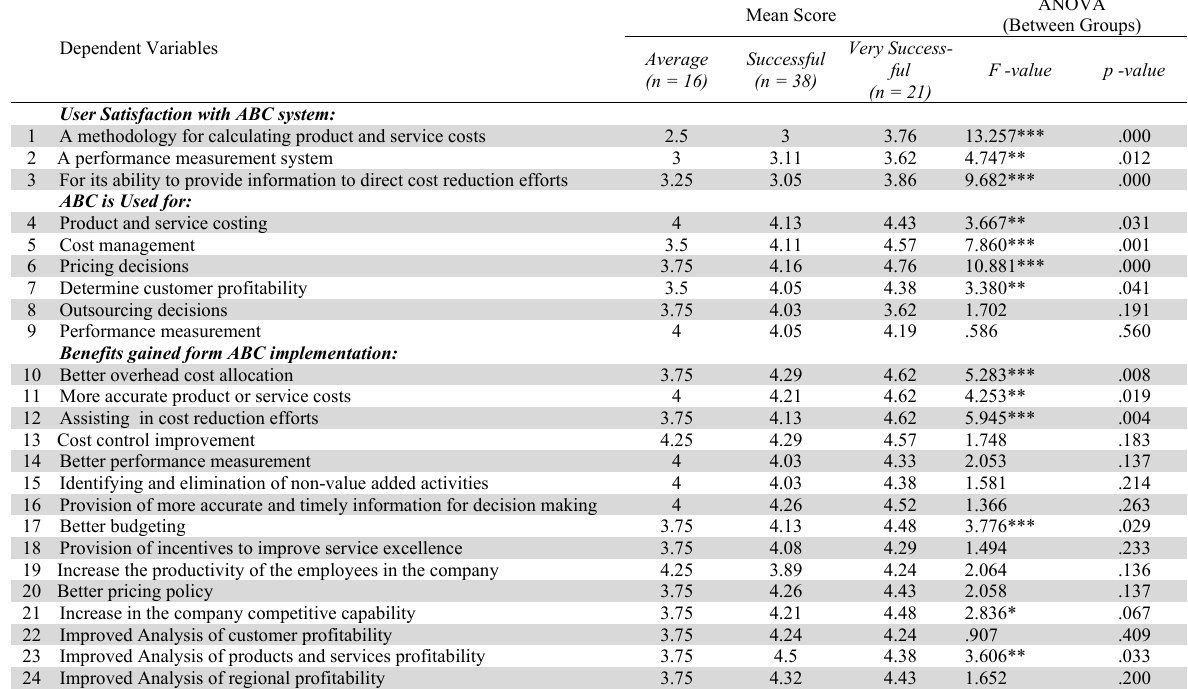
Analysis of variance – Single Item Dependent Variables